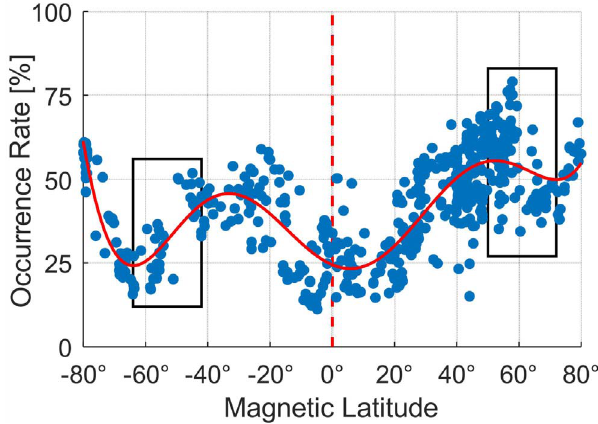
Figure 4. The variation of the occurrence rate of DDMs at each station with its magnetic latitude. The red dotted line in the fi gure represents the magnetic equator. The solid red line is the trendline obtained by polynomial fi tting to each point in the fi gure. The black rectangle represents the area where the occurrence rate of DDMs in the northern/southern hemisphere shows a downward/upward trend as the magnetic latitude